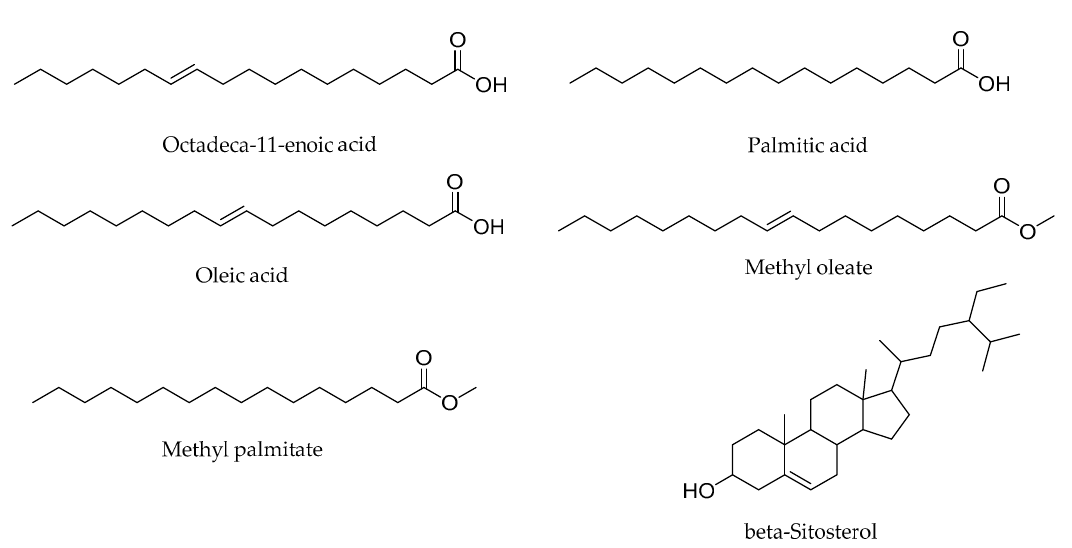
Figure 2. Chemical structures of identified major bioactive components from the n-hexane fraction of P. huayllabambana .